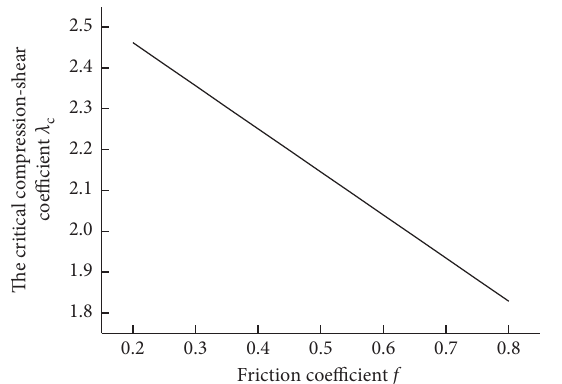
Figure 14: Relationship between critical compression-shear co- efficient of closed crack and friction coefficient of crack surface ( θ � 70 °